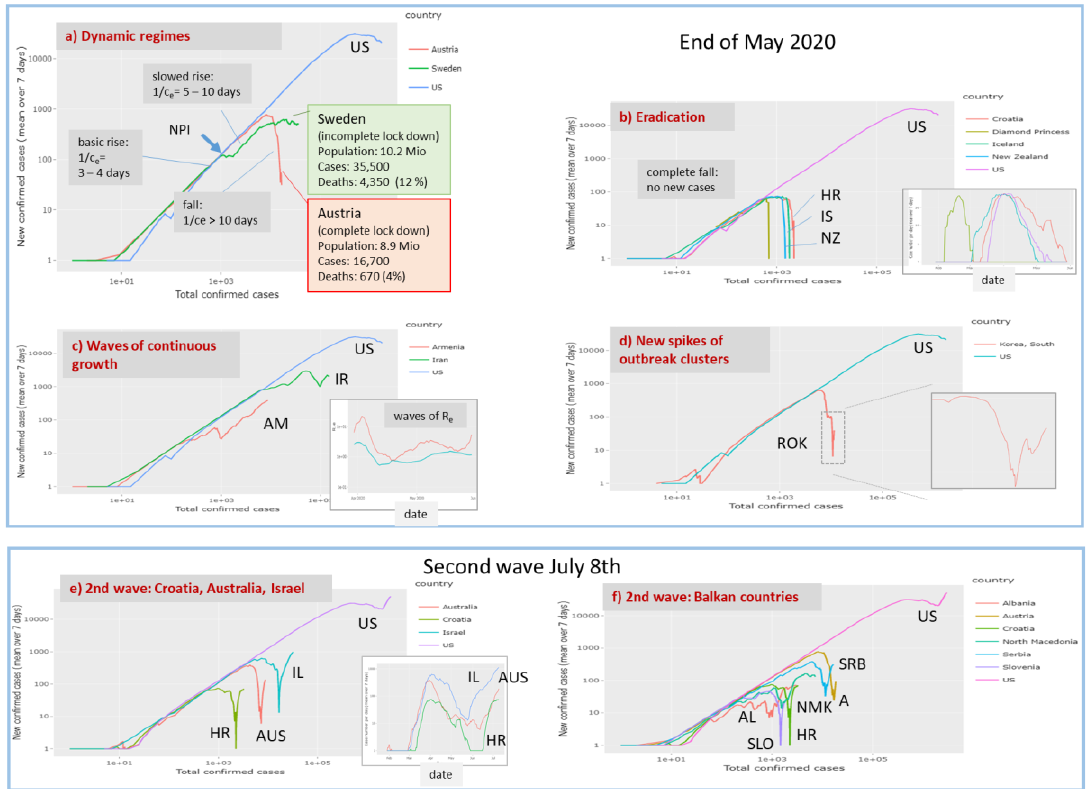
Figure 10. Example trajectories indicating different dynamic regimes of Covid-19: ( a ) Basic rise and falling regimes refer to transmission intervals of 3–4 and more than 10 days, respectively. They were observed in European countries under complete lock down such as Austria. Incomplete lock down as applied in Sweden only slowed down spread of epidemic. It associates with roughly two times more infections and a more than four-fold death-toll. ( b ) Eradication of epidemic can be expected in island states (Iceland, New Zealand) and other relatively small countries (e.g., Croatia) showing disappearance of new cases two to three months after the outbreak (see epi-curves in the insertion). Another example of eradication is Covid-19 spread at the Princess Diamond cruise liner with about 760 infections. ( c ) Wave-like up and downs of epidemic were observed in Armenia and Iran. The trajectories transform into wave-like oscillations of the e ff ective reproduction number (insertion). ( d ) A new spike of cases is July in selected countries, especially, ( f ) at the Balkan. The trajectory for US is shown for